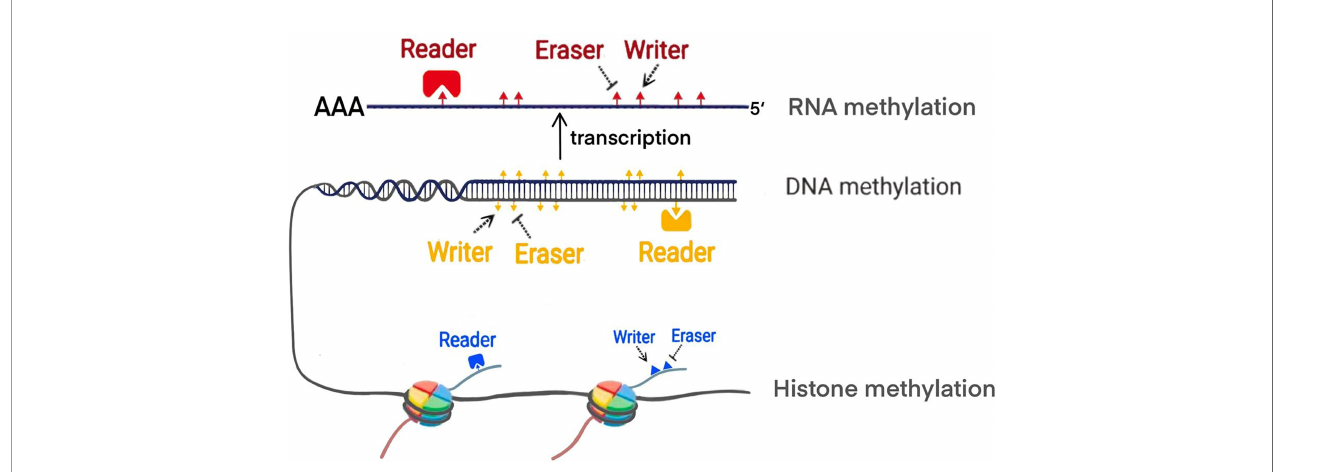
FIGURE 1 | The modi fi cation of methylation by writer, eraser